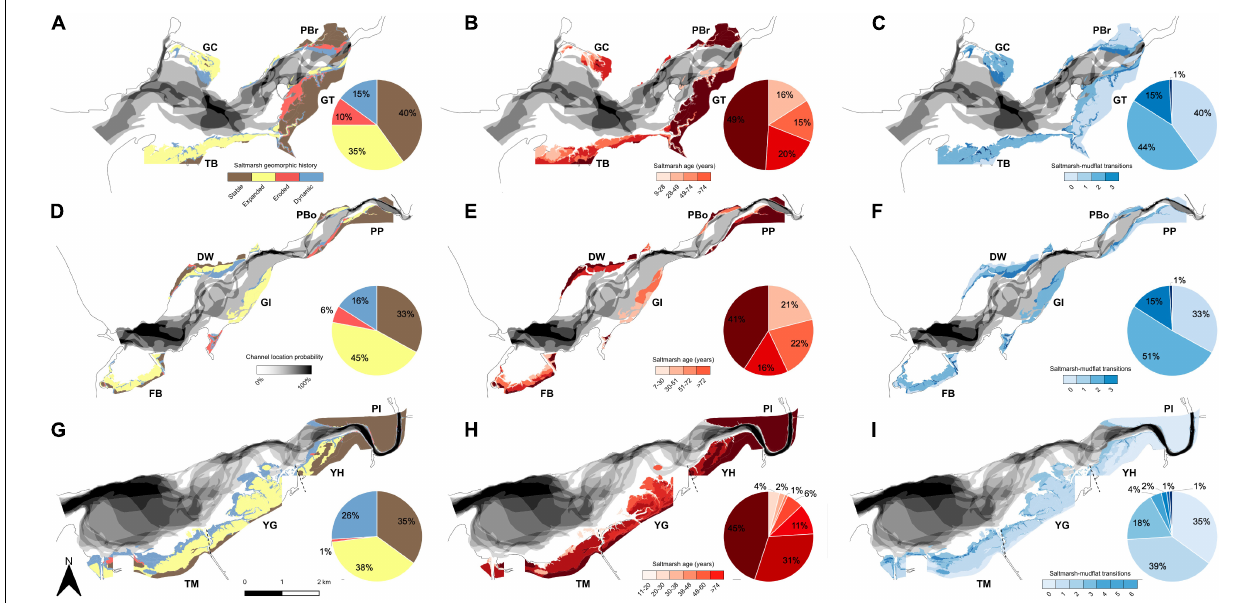
FIGURE 3 | Tidal channel and salt marsh change for the (A–C) Glaslyn-Dwyryd, (D–F) Mawddach and (G–I) Dyfi estuaries between 1946 and 2013. Channel shifts are indicated in gray to black: the darker the color the more stable (spatially fixed) the channel over the observation period. Left panels (A,D,G) show how marshes have changed over time. Brown areas represent stable marshes that remained unchanged throughout the study period. Yellow and red areas represent areas that expanded and eroded, respectively. Blue areas represent dynamic marshes that cycled between phases of erosion and expansion. The middle panels (B,E,H) show marsh ages (darker colors are older marshes). Right panels (C,F,I) show number of times an area transitioned between marsh and mudflat states (dark colors represent more transitions). Pie charts show the percentage of total marsh area represented by each category. Labels refer to the names of salt marsh sites (GC, Glaslyn Cob; TB, Traeth Bach; GT, Glastraeth; PBr, Pont Briwet; FB, Fairbourne; DW, Dwynant; GI, Garth Isaf; PP, Penmaenpool; PBo, Pont Borthwnog; TM, Traeth Maelgwyn; YG, Ynys Greigiog; YH, Ynys Hir, and; PI, Penmaen Isa).